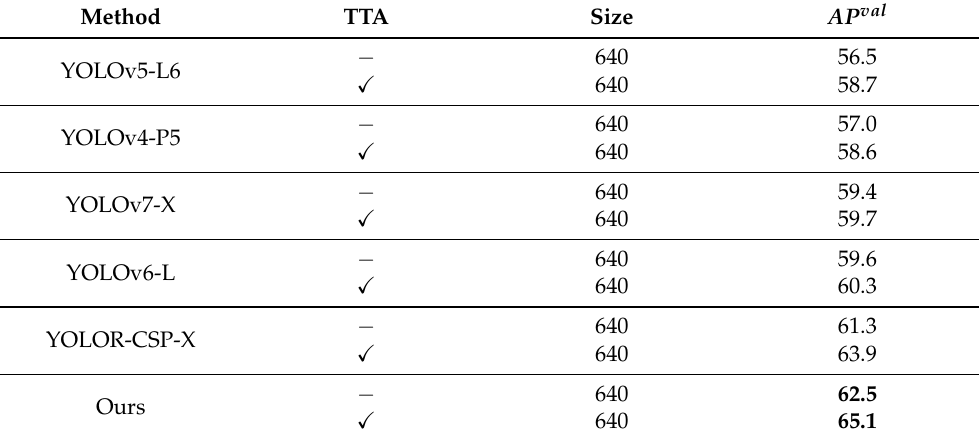
Figure 8. Comparison of results with one-stage object detection methods in terms of inference speed. Table 3. Results of the one-stage object detection methods when TTA is used or not ( (cid:88) denotes use, − denotes not).